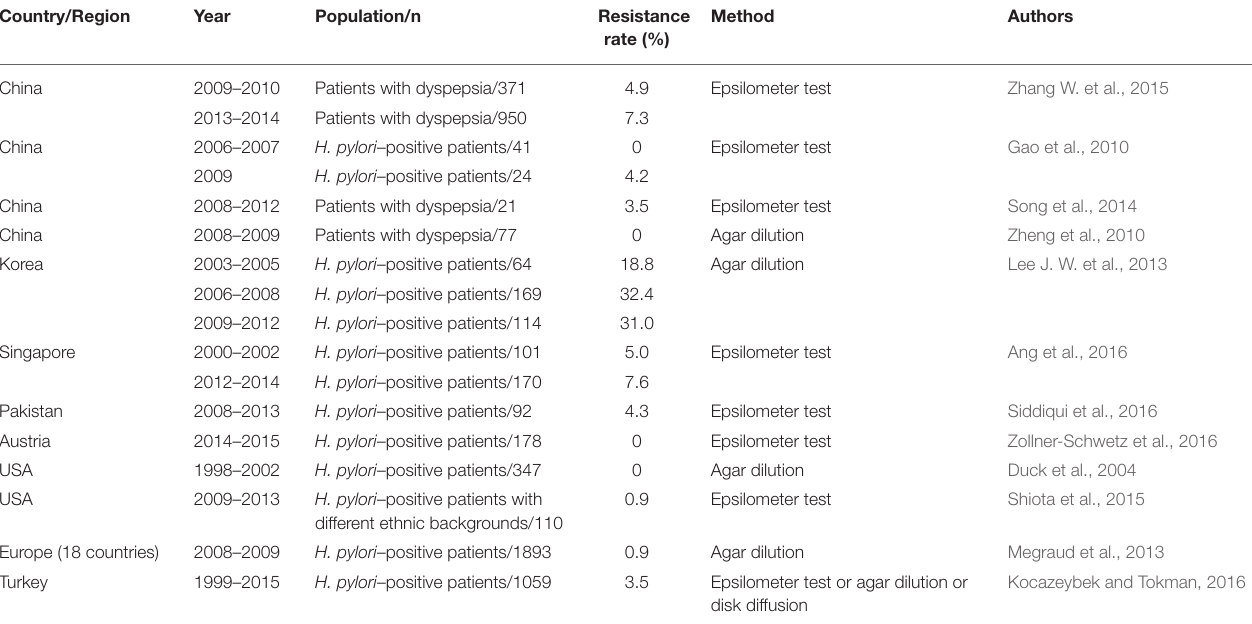
TABLE 6 | Primary H. pylori tetracycline resistance.